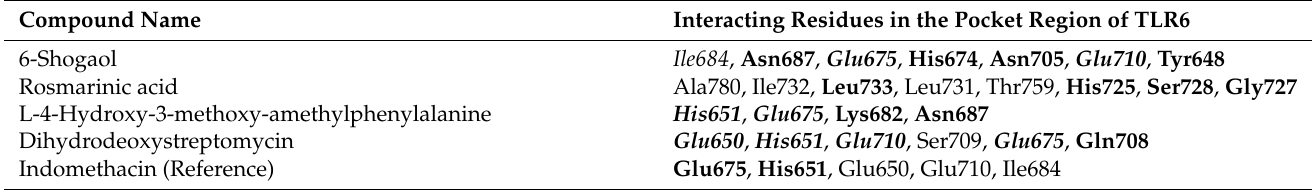
Table 5. Interacting residues of the main ZO and AS docked compounds into the human TLR6. Indomethacin was used a reference compound.